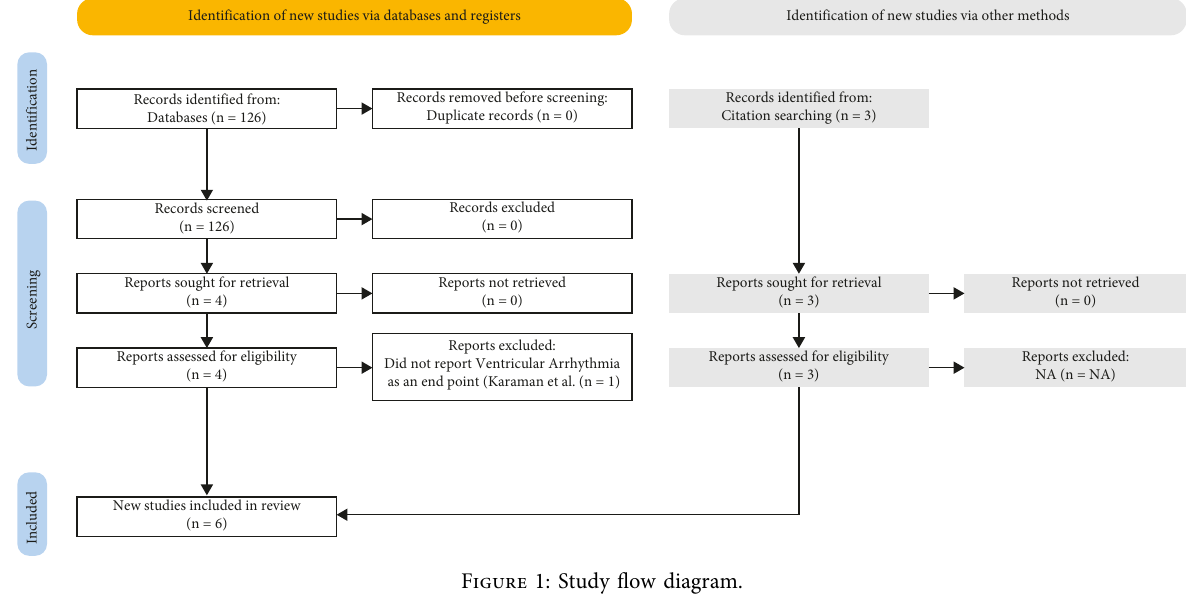
Figure 1: Study flow diagram.